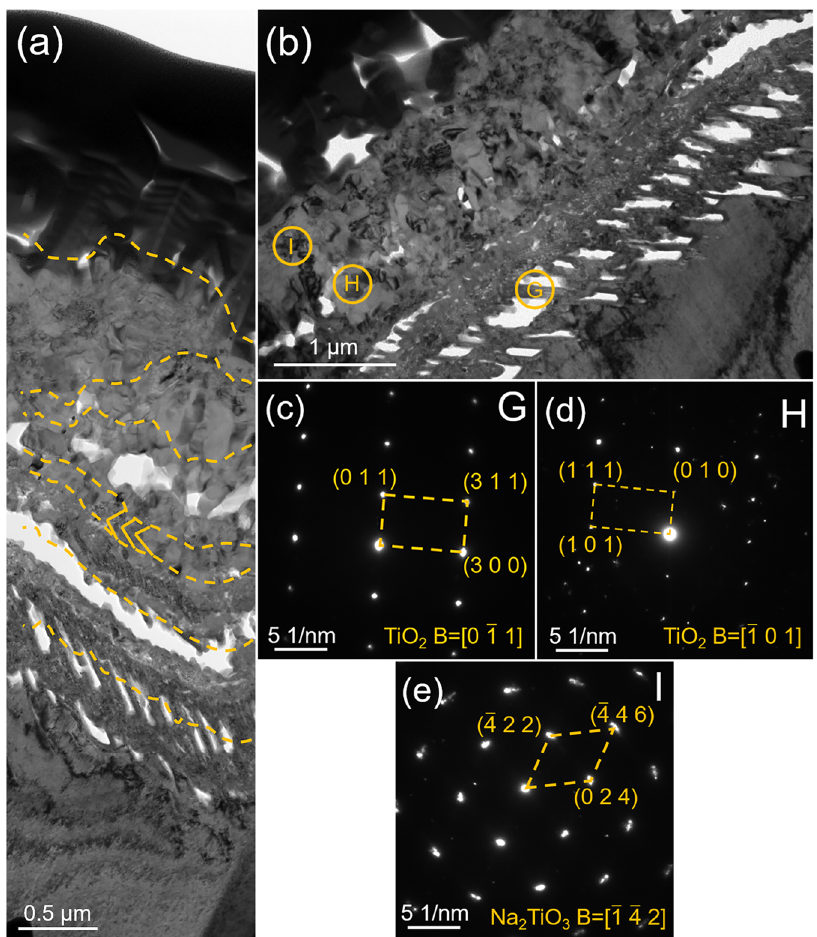
Fig. 7 TEM results of Ti exposed to the continuous NaCl solution spraying for 20 h at 600 °C. a STEM bright fi eld image, b the TEM enlarged view, c SAED patterns of area G, d SAED patterns of area H, and e SAED patterns of area I.